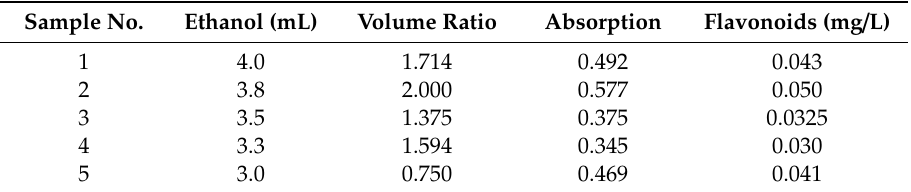
Table 1. E ff ect of the ethanol concentration on flavonoid Table 1. Effect of the ethanol concentration on flavonoid extraction.